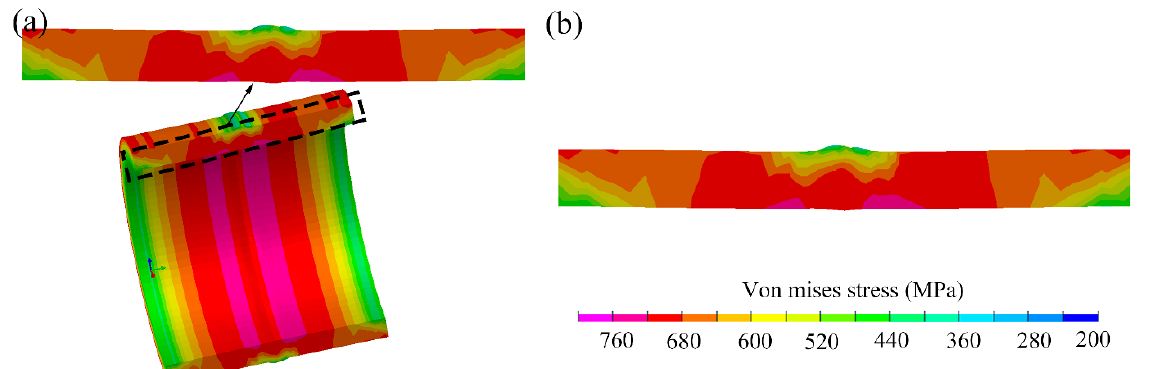
Figure 3. Schematic diagram of verification model: ( a ) 3D model, ( b ) 2D rotational model.